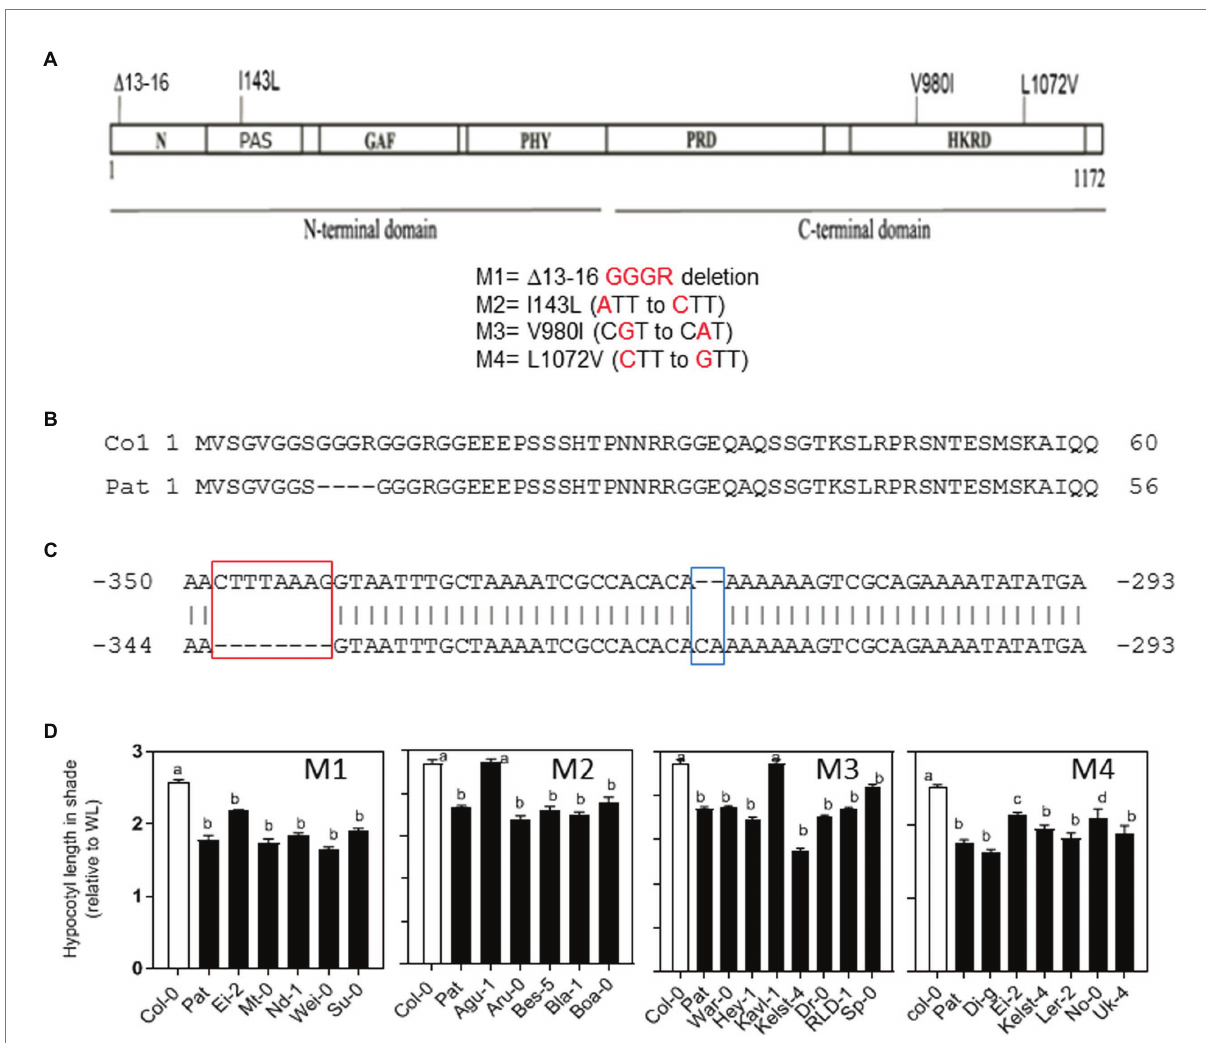
FIGURE 2 PHYB polymorphisms between Col-0 and Pat accessions. (A) PHYB polymorphisms in the coding region between Col-0 and Pat. The diagram shows the four polymorphisms in the N-and C-termini domains (M1 = deletion, M2 = I143L, M3 = V980I, and M4 = L1072V). (B) Col-0 and Pat amino- acid sequences show the GGGR deletion of Pat in the amino termini of PHYB protein. (C) The two indels polymorphisms in the promoter of PHYB gene between Col-0 and Pat tested in this study. The deletion of 8 nucleotides at position − 341/ − 334, and the insertion of 2 nucleotides at position − 318/ − 319 in the Pat promoter up to ATG starting codon. (D) Natural variation for hypocotyl SAR index calculated as the ratio of hypocotyl length in simulated shade and WL between accessions sharing the same PHYB- Pat polymorphism at the positions M1, M2, M3, and M4. Significant differences between means are shown with different letters by one-way ANOVA followed by Bonferroni post-test ( p < 0.05). Each bar represents mean ± SE ( n =